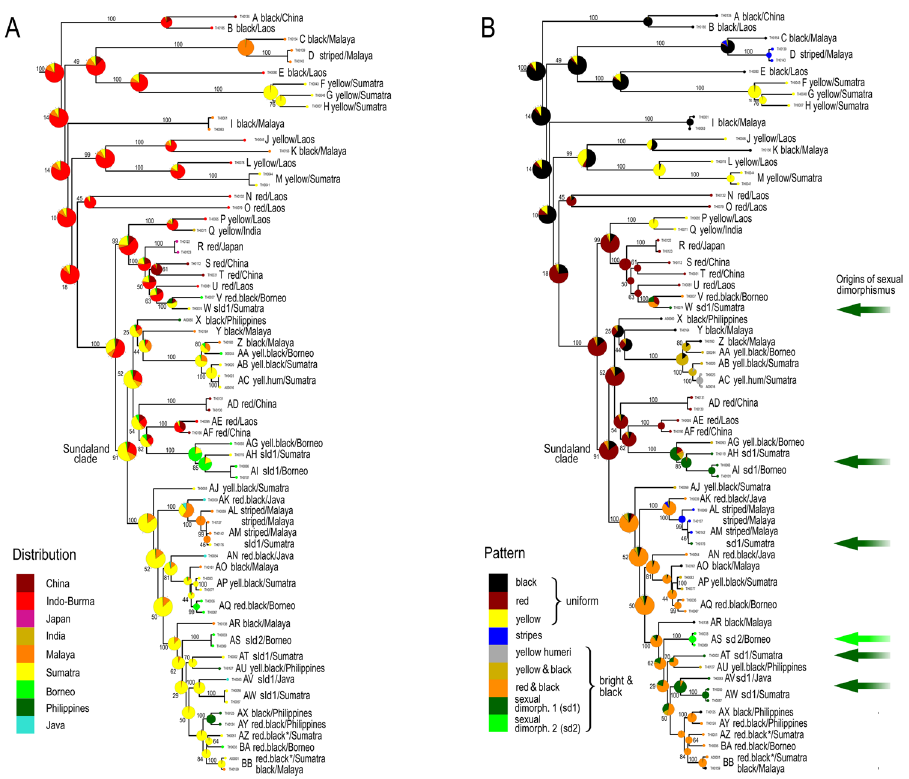
Figure 3. Phylogenetic reconstruction of ancestral states: ( A ) geographic origin; ( B ) colour